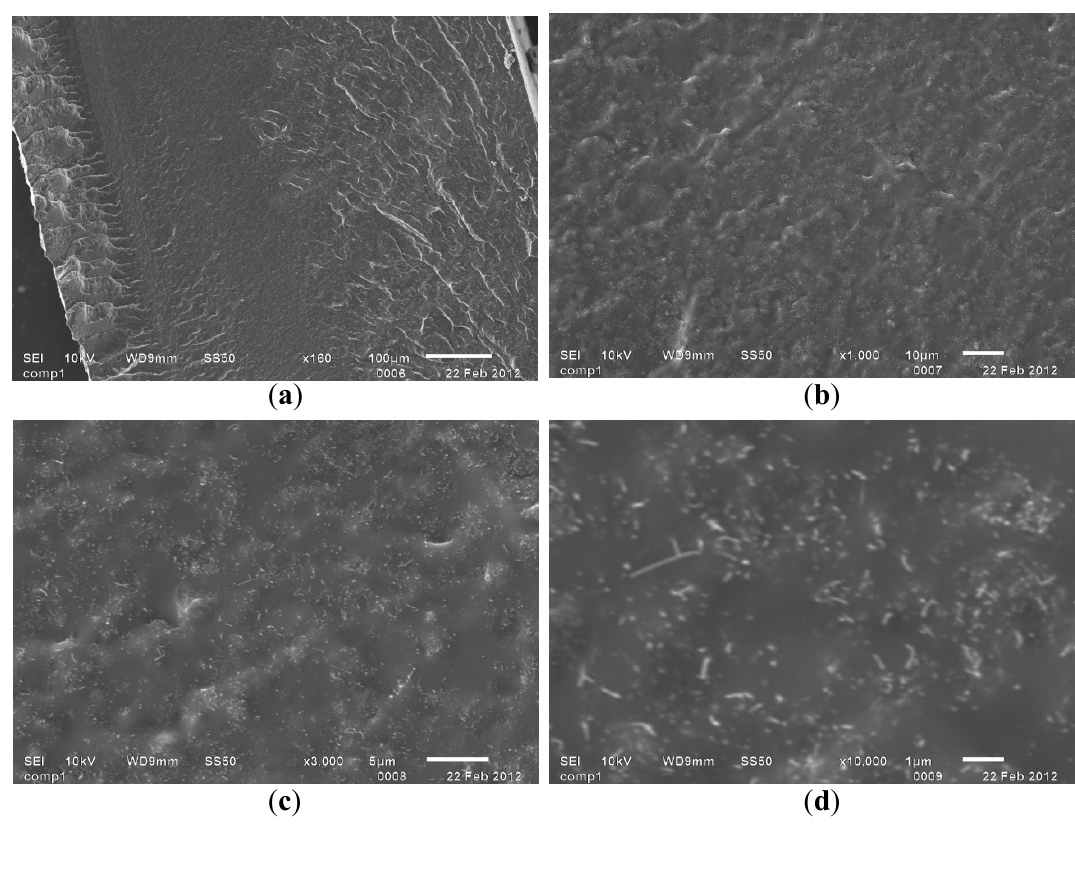
Figure 7. SEM images showing dispersed MWCNTs on a cross section of polymer nanocomposite that was fractured in liquid nitrogen. Nanocomposite contains around 7 wt.% of functionalized carbon nanotubes throughout its matrix. Observation was made on same area of surface with following increasing magnification: ( a ) 160×; ( b ) 1000×; ( c ) 3000×; and ( d )